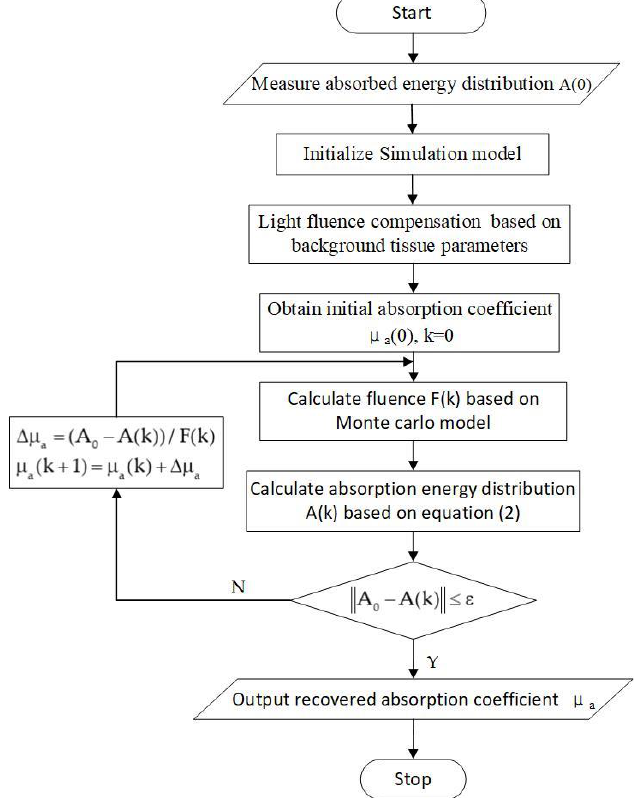
Figure 1. Flow chart for quantitative reconstruction the distribution of optical absorption coefficients.